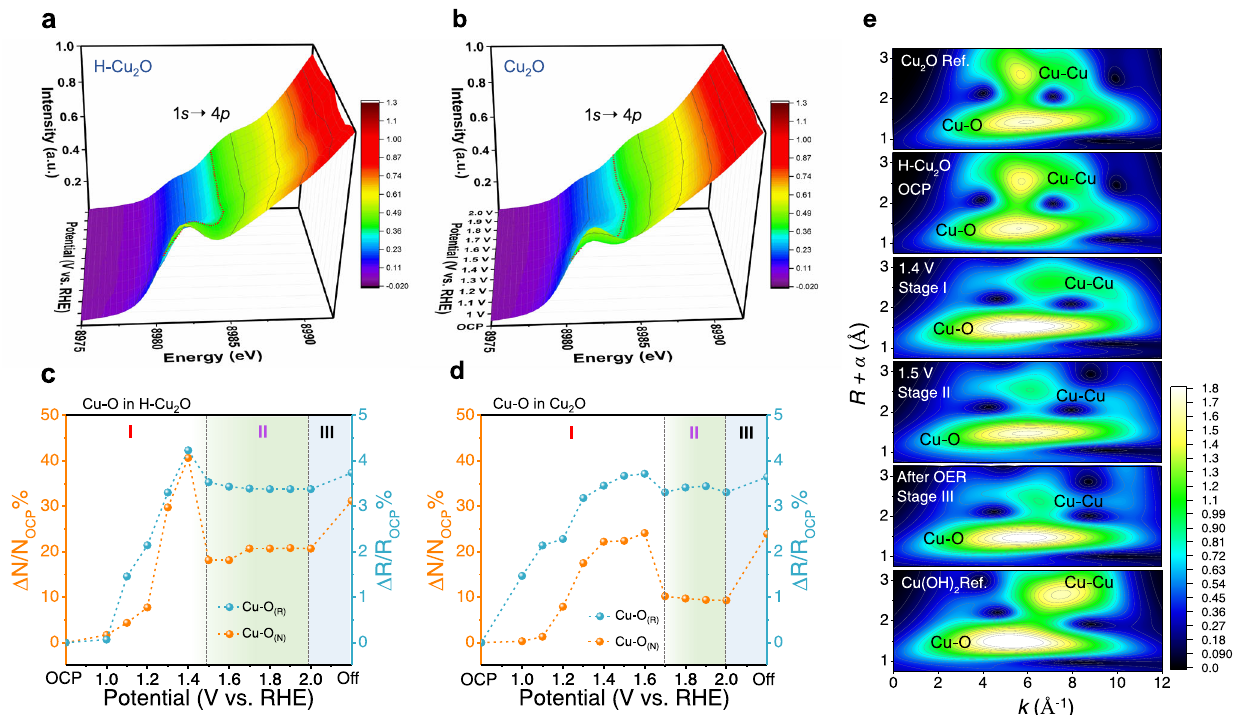
Fig.3|UnderstandingthecorrelationbetweenOERactivityandlocalstructure transformation. a , b 3D patterns of operando Cu K -edge XANES of H-Cu 2 O and Cu 2 O catalysts. c , d Structural coherence change of Cu – O in EXAFS coordination number (N) and bond length (R) of H-Cu 2 O and Cu 2 O catalysts under an applied